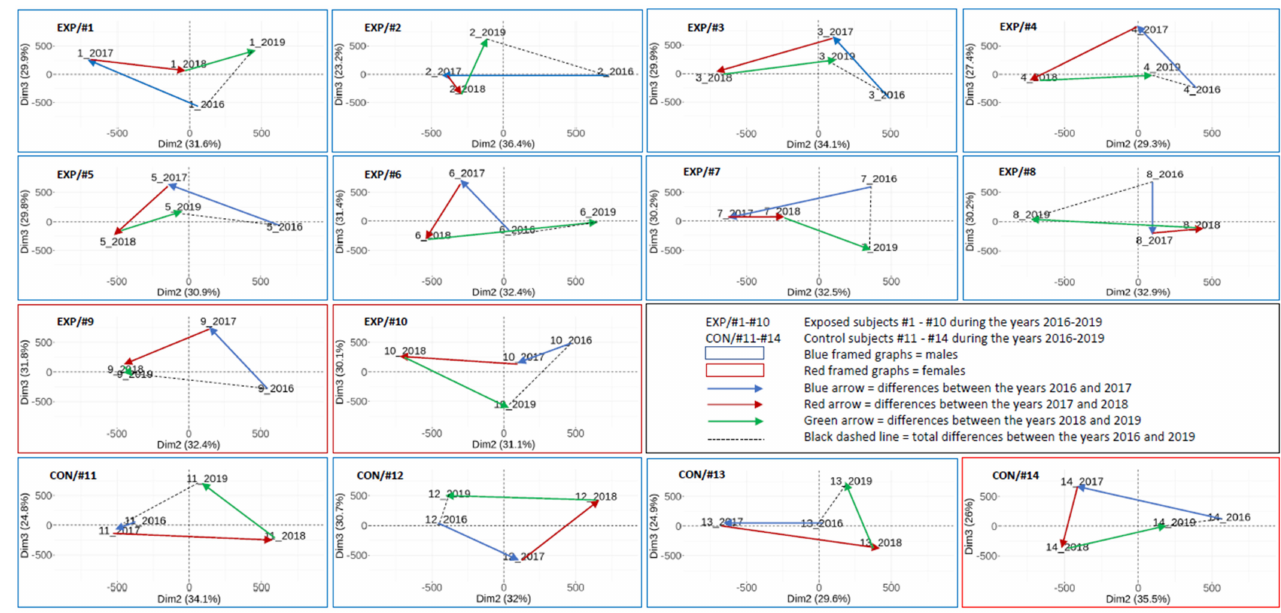
Figure 3. Individual DNA methylation pattern trajectories of the exposed and control subjects analyzed by PCA in four consecutive years: results of the whole CpG data set analyzed by array chips. Three-year differences between the years 2016 and 2019 (dashed line) were used for the calculations of the range of changes in the exposed and control subjects (details in Section 2.3.3).